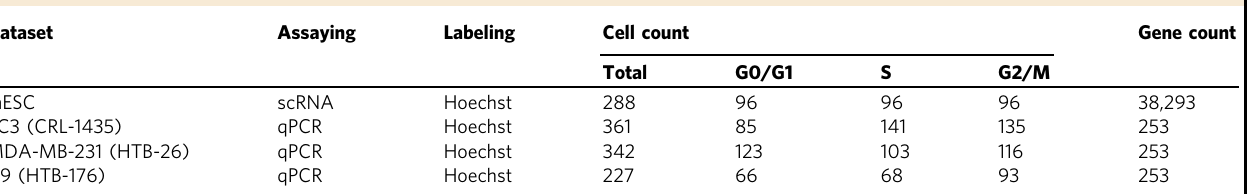
Table 1 Labeled cell-cycle scRNA-seq